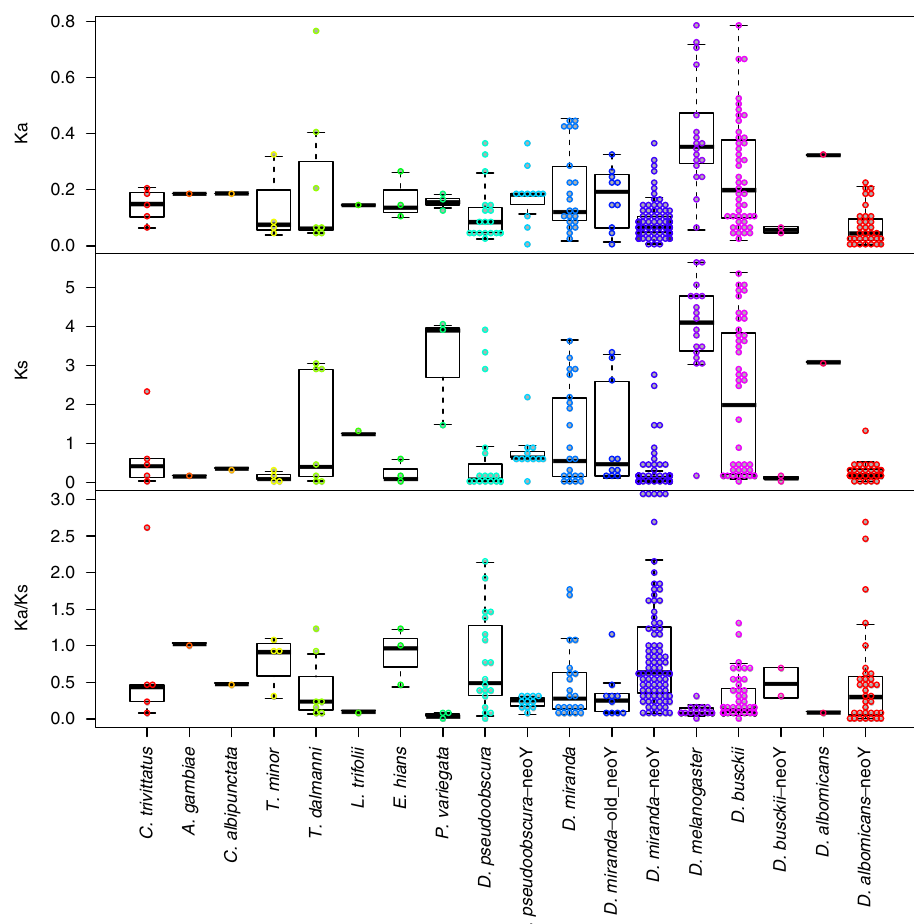
Fig. 5 Divergence analysis of Y linked genes. Shown are rates of sequence evolution of Y-linked genes and their closest paralogs within the female genome. For Drosophila species with neo-sex chromosomes, we show divergence between neo-X/neo-Y homologs (i.e., Y-linked genes with their closest homolog on the neo-X) separately from other Y-linked genes. Shown are rates of amino acid evolution (Ka), rates of synonymous evolution (Ks), and their ratio (Ka/Ks). Note that Ka/Ks values > 3 are plotted at